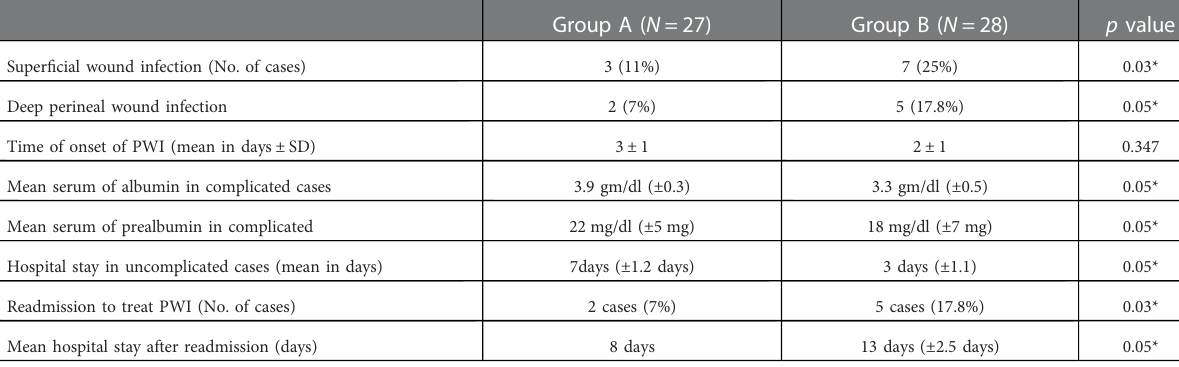
TABLE 2 Postoperative data in both